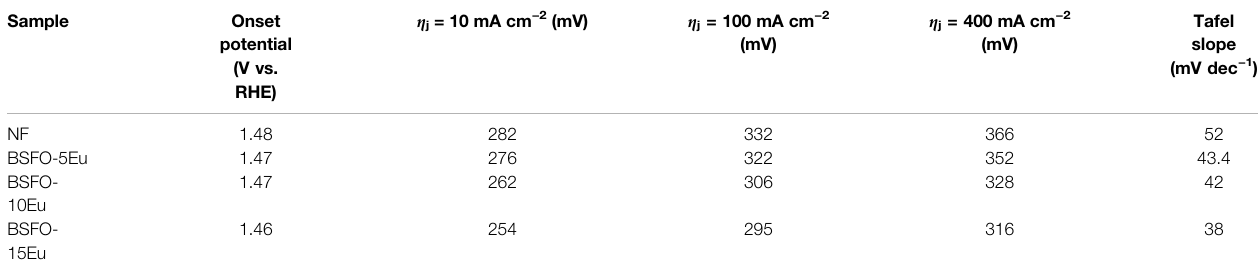
TABLE 2 | OER performances of NF and BSFEO coated on NFs.